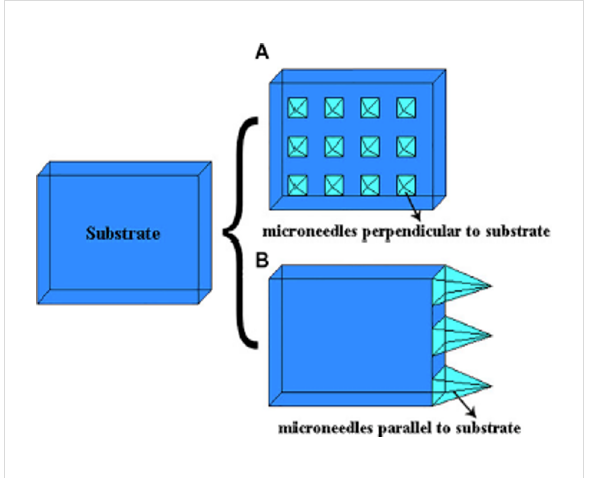
Figure 2: Schematic showing in-plane and out-of-plane microneedle arrays [53]. Figure 2 was reproduced from [53] (© 2019 X. He et